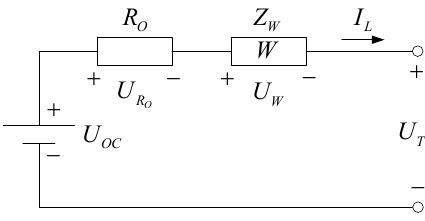
Figure 3. The simplified EIS